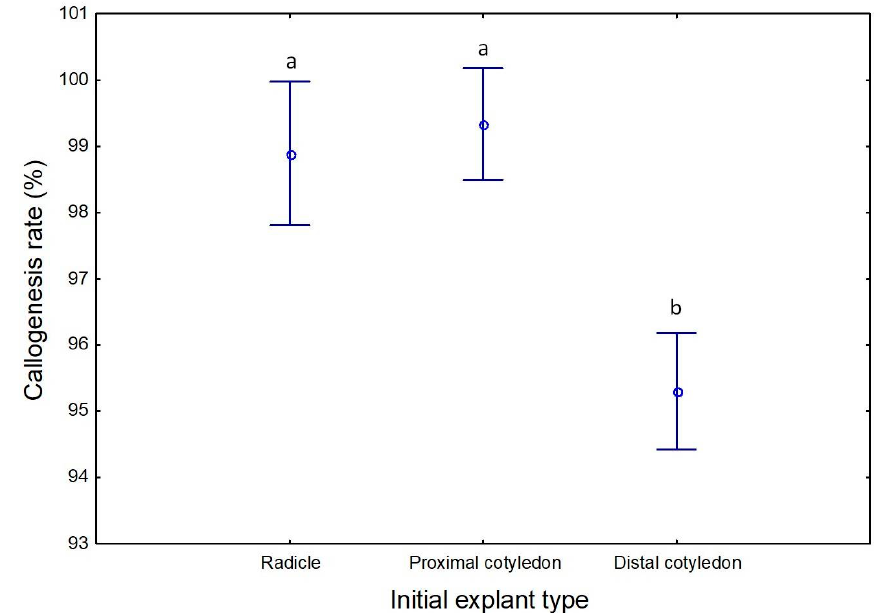
Figure 1. Callus formation rate on induction media, according to the initial explant type, radicle, proximal, and distal region of cotyledons. Different letters correspond to statistically signi fi cant differences ( p ≤ 0.05).